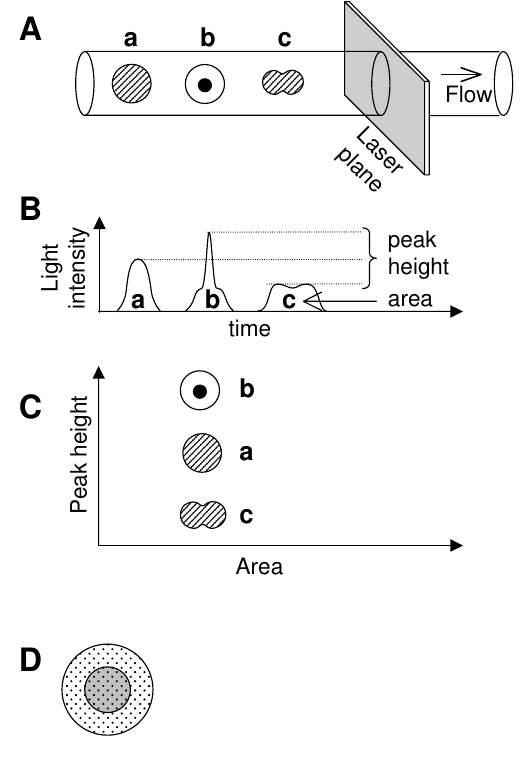
Figure 2 Schematic representation of the particle structures, with peak height and area . A: Single cell with uniform content (a), single cell without uniform content (b), and dou- blet cells with uniform content (c). B: Time course of signals.